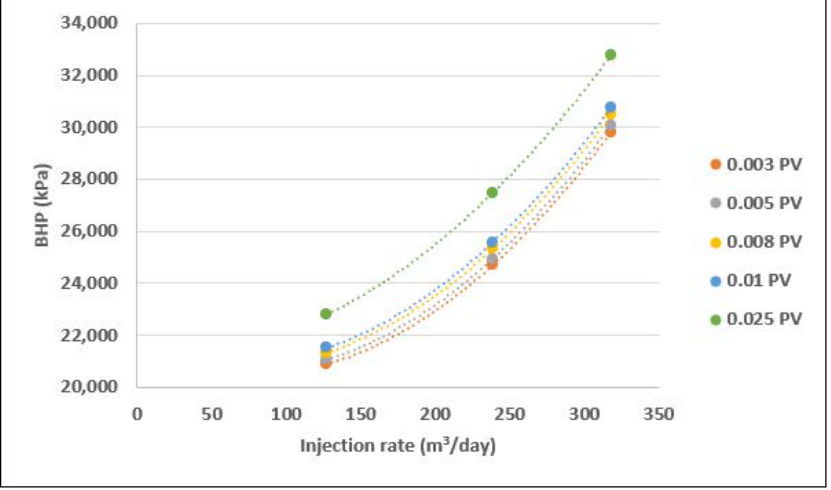
Figure 18. BHP versus injection rate for polymer injection at several